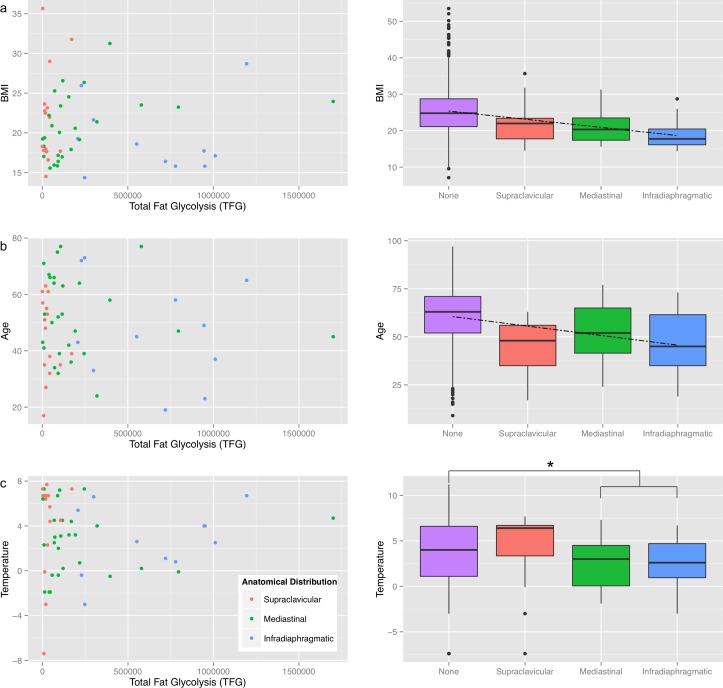
Differences in BAT activation between individuals and categories.The first column depicts the total fat glycolysis (TFG) in relation to BMI (a), age (b) and external temperature (c). As can be guessed by the visual impression of the scatter plots, no clear correlation between either of the factors and the TFG could be established. In the second column however, the same data is shown and instead of using the metabolic activity, it is simply ordered by the morphological type of activation, showing clearly more activated depots with lower BMI, age and temperature. The dashed lines in (a) and (b) represent the significant linear correlation (p > 0.05), the asterisk (*) in (c) marks the only statistically significant difference (p<0.0125) in absence of a linear correlation.